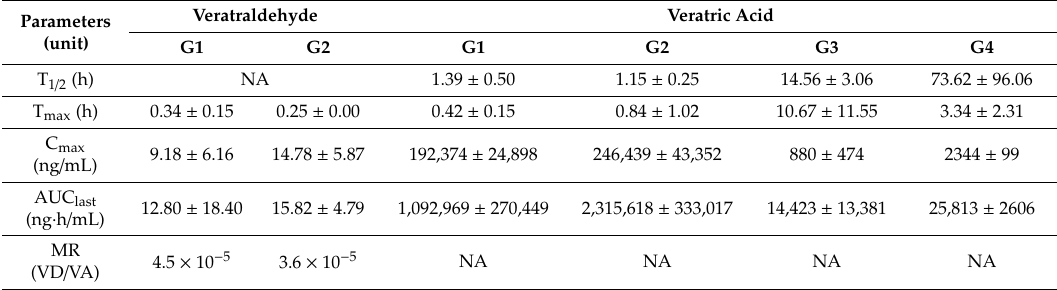
Figure 4. Plasma concentration versus time profiles for veratraldehyde ( a ) and veratric acid ( b ) after oral (G1, 300 mg / kg; G2, 600 mg / kg) and percutaneous (G3, 300 mg / kg; G4, 600 mg / kg) administration of veratraldehyde ( n = 3). Table 5. Pharmacokinetic parameters of veratraldehyde and veratric acid in rats ( n = 3).